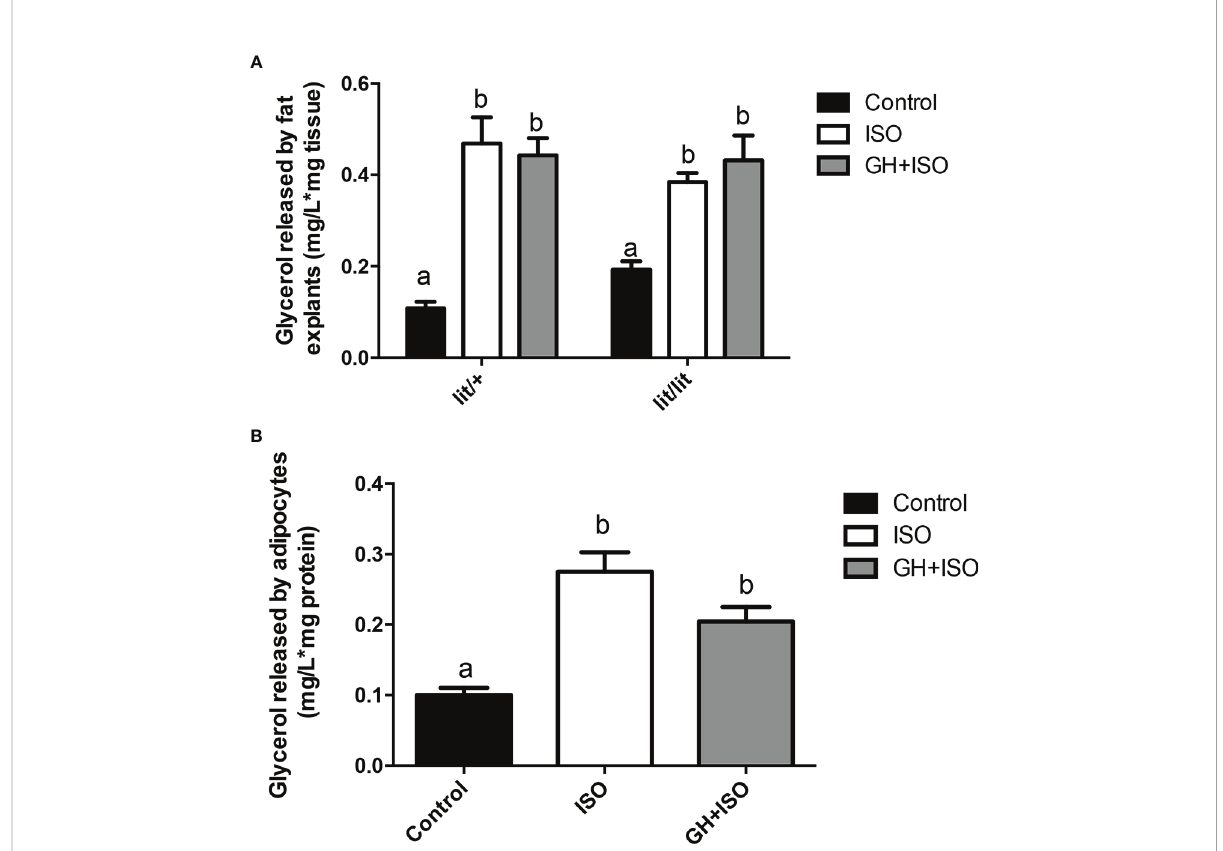
FIGURE 6 Effect of GH on isoproterenol-induced lipolysis in adipose tissue and adipocytes. (A) Effect of GH on isoproterenol-induced lipolysis in adipose tissue explants. Inguinal subcutaneous fat explants from ad lib-fed lit/+ mice and lit/lit littermates were cultured with 10 m M isoproterenol (ISO), 10 m M ISO and 100 ng/ml GH, or vehicle control for 4 h, and glycerol released into the medium was measured. (B) Effect of GH on isoproterenol-induced lipolysis in adipocytes. Adipocytes were differentiated from the stromal vascular fraction cells isolated from ad lib-fed lit/ lit inguinal subcutaneous fat. Adipocytes were cultured with 10 m M ISO, 10 m M ISO and 100 ng/ml GH, or vehicle control for 4 h, and glycerol released into the medium was measured. Data are expressed as mean ± SEM (n = 5 mice). Means labeled with different letters are statistically different ( P < 0.05). * represents